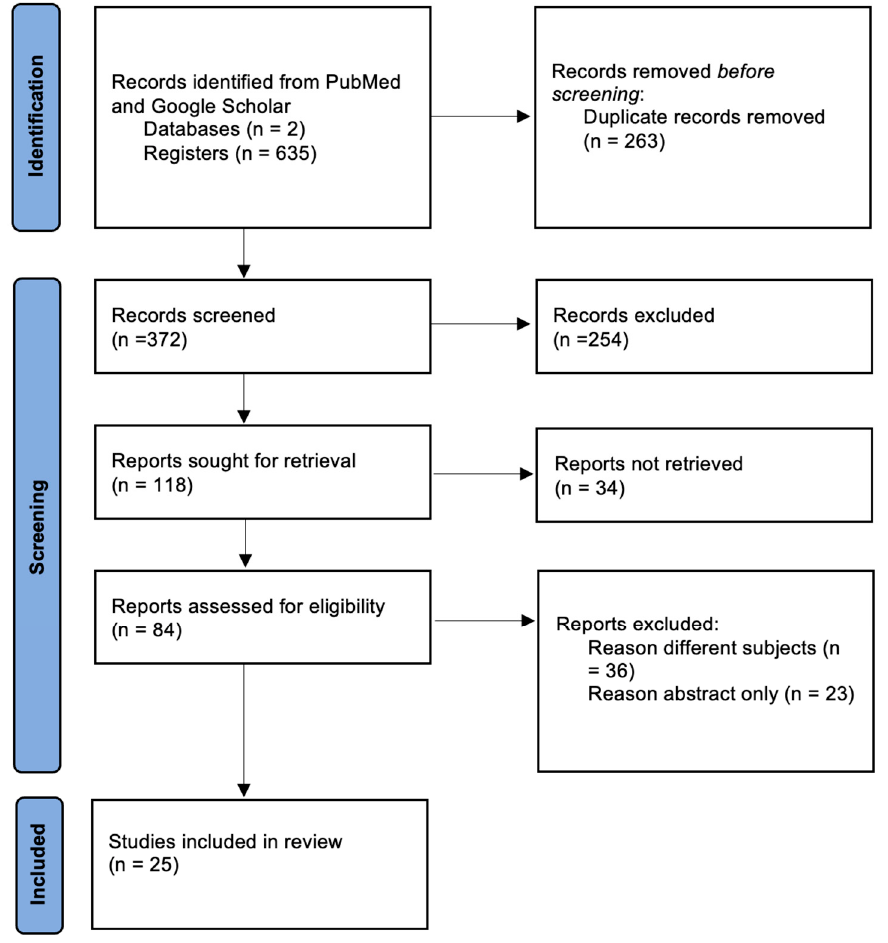
Figure 1. Preferred Reporting Items for Systematic Reviews and Meta-Analyses (PRISMA) flowchart for study screening, selection, and inclusion.